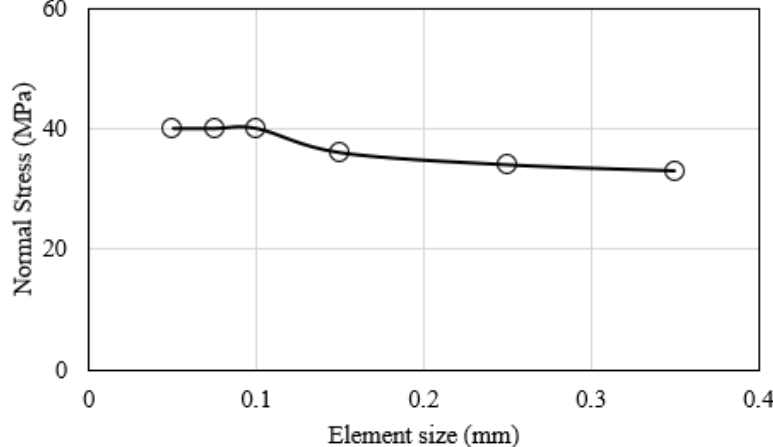
Figure 7. FE model of a DCB specimen demonstrating element mesh and boundary conditions.